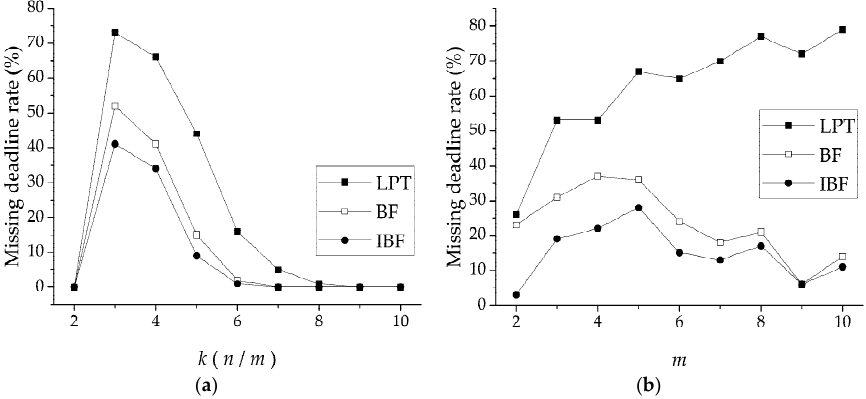
Figure 8. Comparison of LPT, BF, and IBF in terms of missed deadline rate (MDR) with ( a ) k (the ratio of the number of tasks n and the number of fine-delay modules m ) and ( b ) variable number of fine delay modules m .